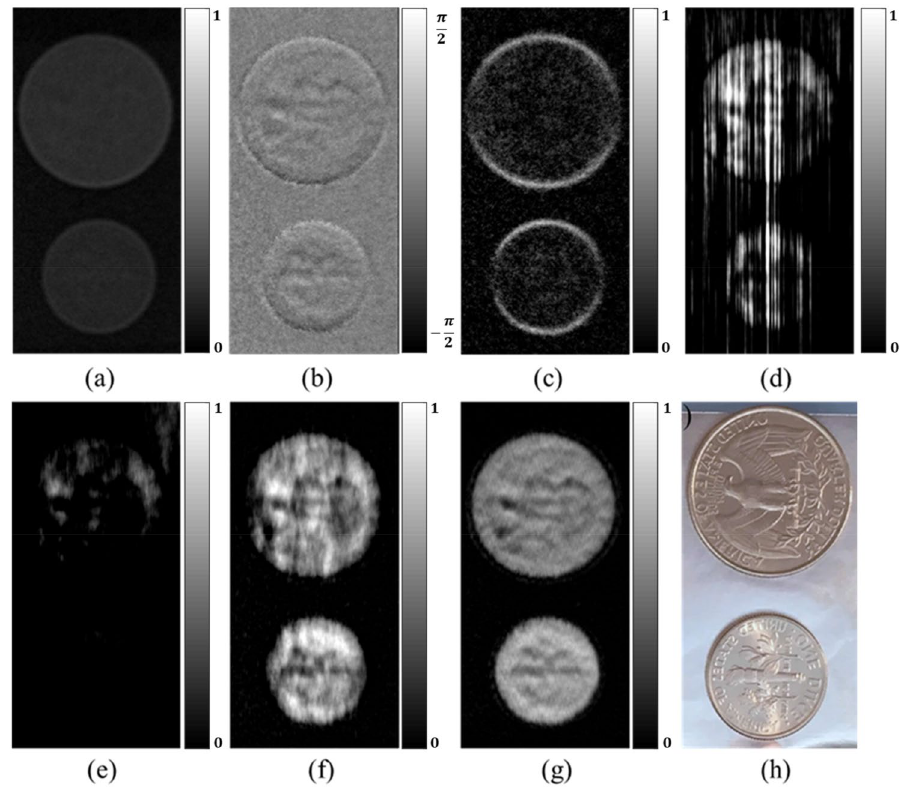
Figure 6. Comparison of PCI retrieval from neutron TLI images of coins. ( a ) Transmission, ( b ) DPCI, ( c ) dark- field, ( d ) direct integration, ( e ) WF filtering, ( f ) iterative method, ( g ) the proposed method, ( h ) visual image. The display windows are same for ( d – g ). The total phase stepping number is